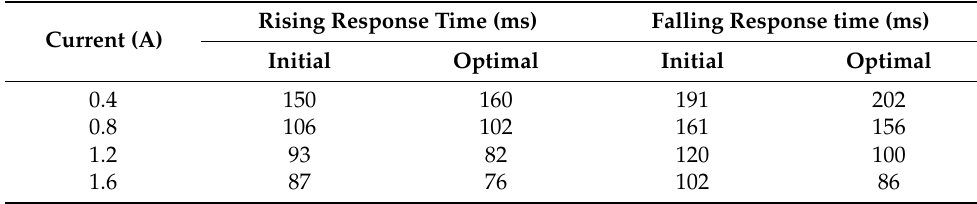
Table 5. Response characteristic of the proposed MR valve.